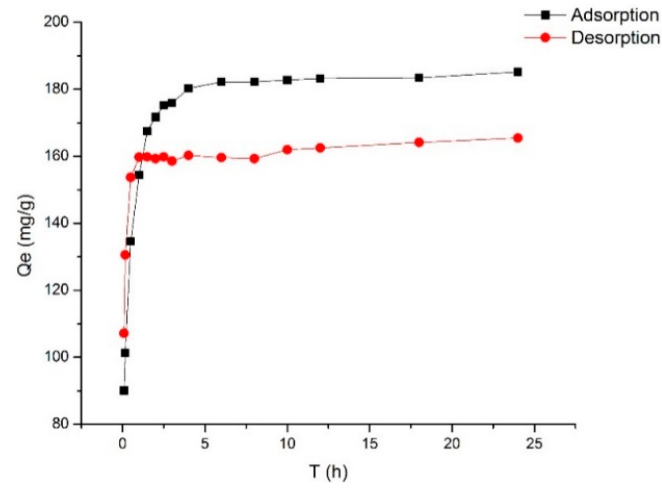
Figure 1. Adsorption kinetics curve and desorption kinetics curve for total PMFs on HPD 300 resin.